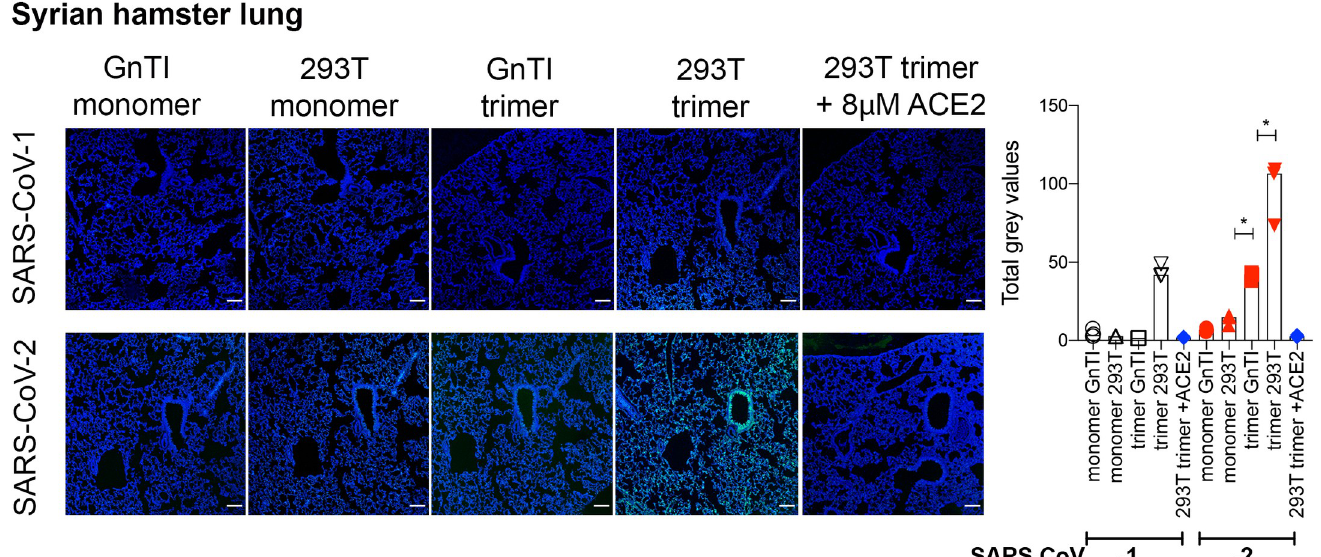
Fig 5. Binding of SARS-CoV-RBD proteins to serial Syrian hamster tissue slides. SARS-COV-RBD proteins (50 μ g/ml) were applied to Syrian hamster lung tissue slides and detected using additional anti-Streptag and goat-anti-mouse antibodies sequentially. Where indicated SARS-CoV-RBD proteins were pre-incubated with recombinant ACE2 protein. Scalebar is 100 μ M. For the quantification, the intensity of gray pixels of stained Syrian Hamster lung tissue slides was measured with ImageJ version 1.52p. � indicates P < 0.05 as determined by an unpaired two-tailed students T-test in the GraphPad software.